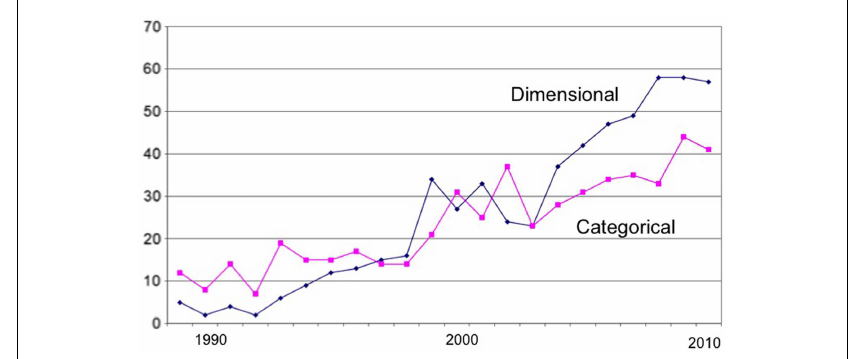
FIGURE 1 | Bibliometrics: dimensional and categorical approaches .